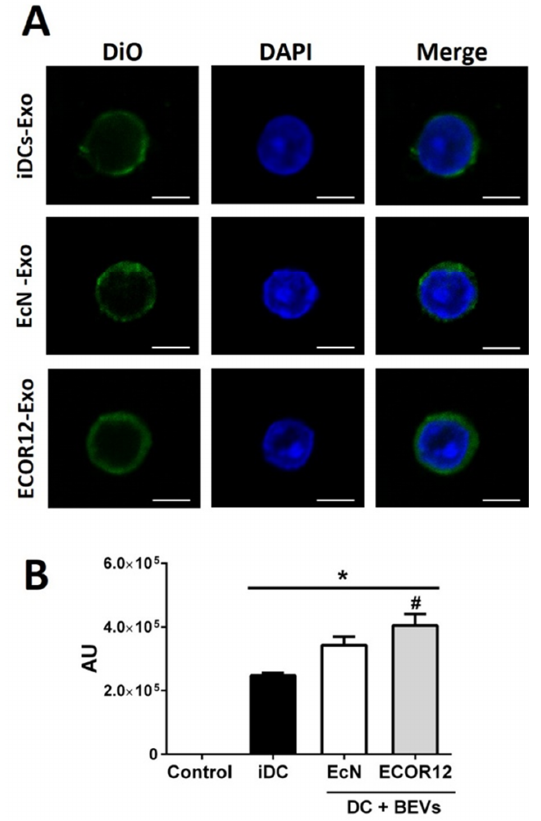
Figure 5. Exosomes derived from BEV-activated DCs are internalized by naïve CD4 + T-cells. ( A ) DIO-labeled DC-derived exosomes (green) isolated from untreated immature DCs or DCs stimu- lated with EcN or ECOR12 BEVs were cultured for 24 h with naïve CD4 + T-cells and analyzed by confocal microscopy. Nuclei were stained with DAPI (blue). Images were analyzed using Fiji image processing package. Scale bars: 5 μm. ( B ) T-cell-associated fluorescence (AU) was recorded for each exosomal sample. In all cases, the number of cells analyzed was between 60 and 100. Data were expressed as mean ± SEM from three independent experiments. * Significance versus exosomes iso- lated from untreated control iDCs, # significance between exosomes isolated from DCs stimulated with EcN or ECOR12 BEVs.